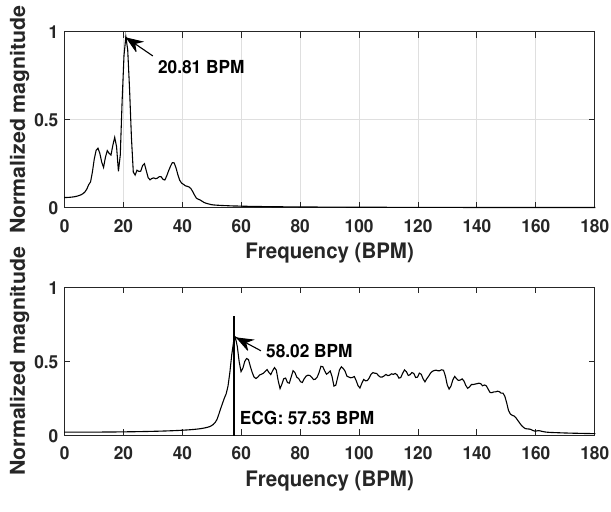
Figure 9. Respiration spectrum ( top ) and heartbeat spectrum ( bottom ) for test example 2.